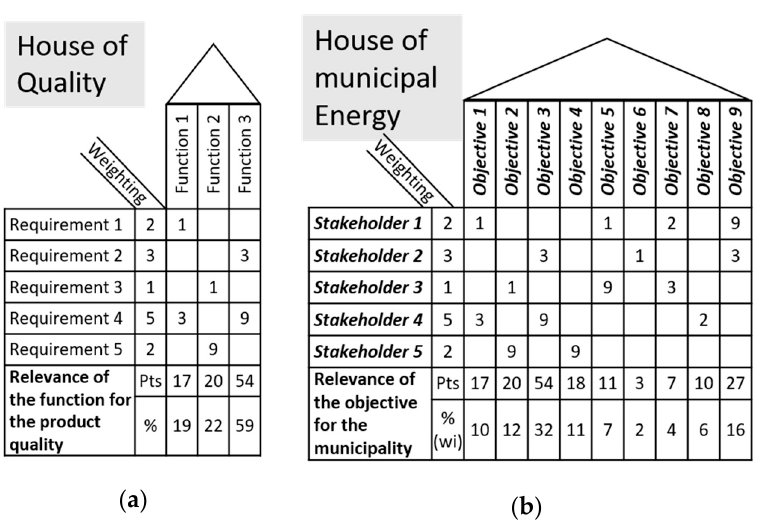
Figure 3. Comparative view of House of Quality (HoQ) and House of municipal Energy (HomE): ( a ) House of Quality (HoQ) from traditional quality function deployment; ( b ) House of municipal Energy (HomE) to assess municipal weighting function.